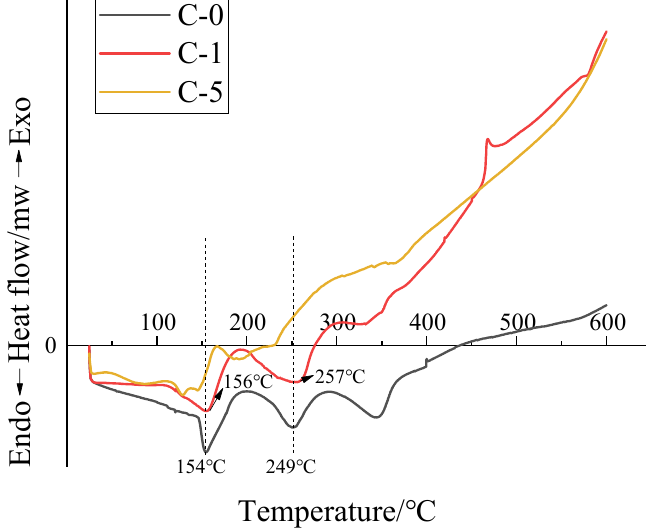
Figure 8. TG ( a ) and DTG ( b ) curves of the Samples.